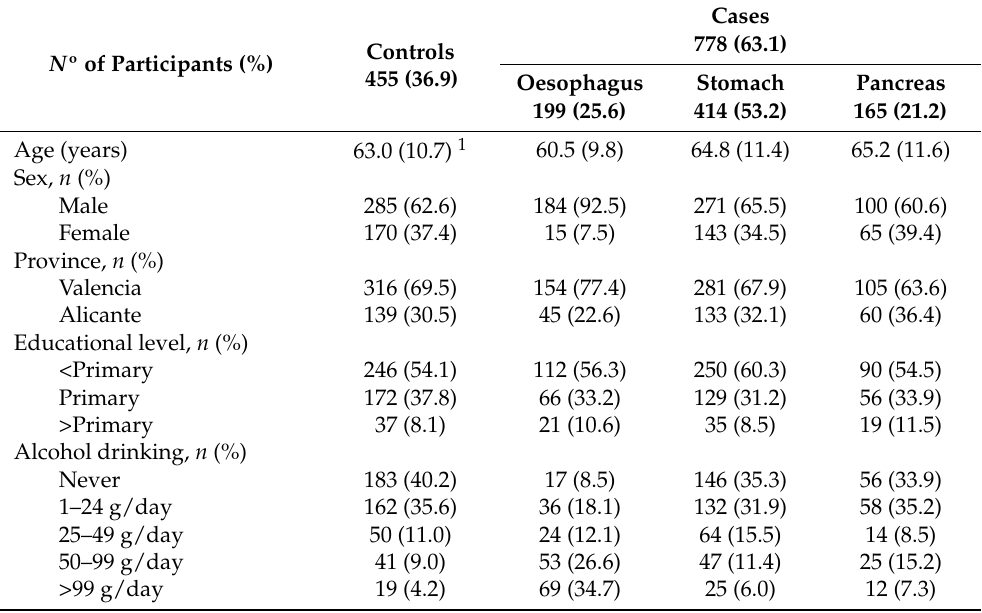
Table 2. Sociodemographic characteristics, lifestyle, and pro-vegetarian food patterns among controls and cancer cases (oesophagus, stomach, and pancreas) of the PANESOES study ( n = 1233).